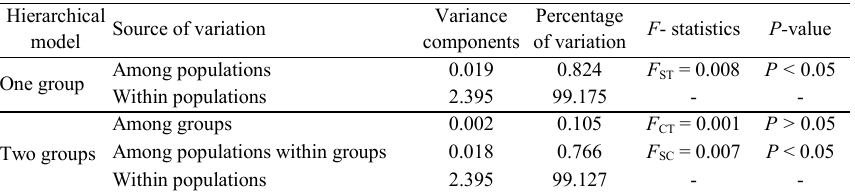
Table 4. Analysis of Molecular Variance (AMOVA) among sampling groups of Prochilodus argenteus . Structure tested: All samplings as a single group and divided in two groups: group 1 (Mainstream ABAr, TMDd and TMDr) and group 2 (Marginal lagoons of CAR, JEQ, PAR, SFR, URU and VEL).